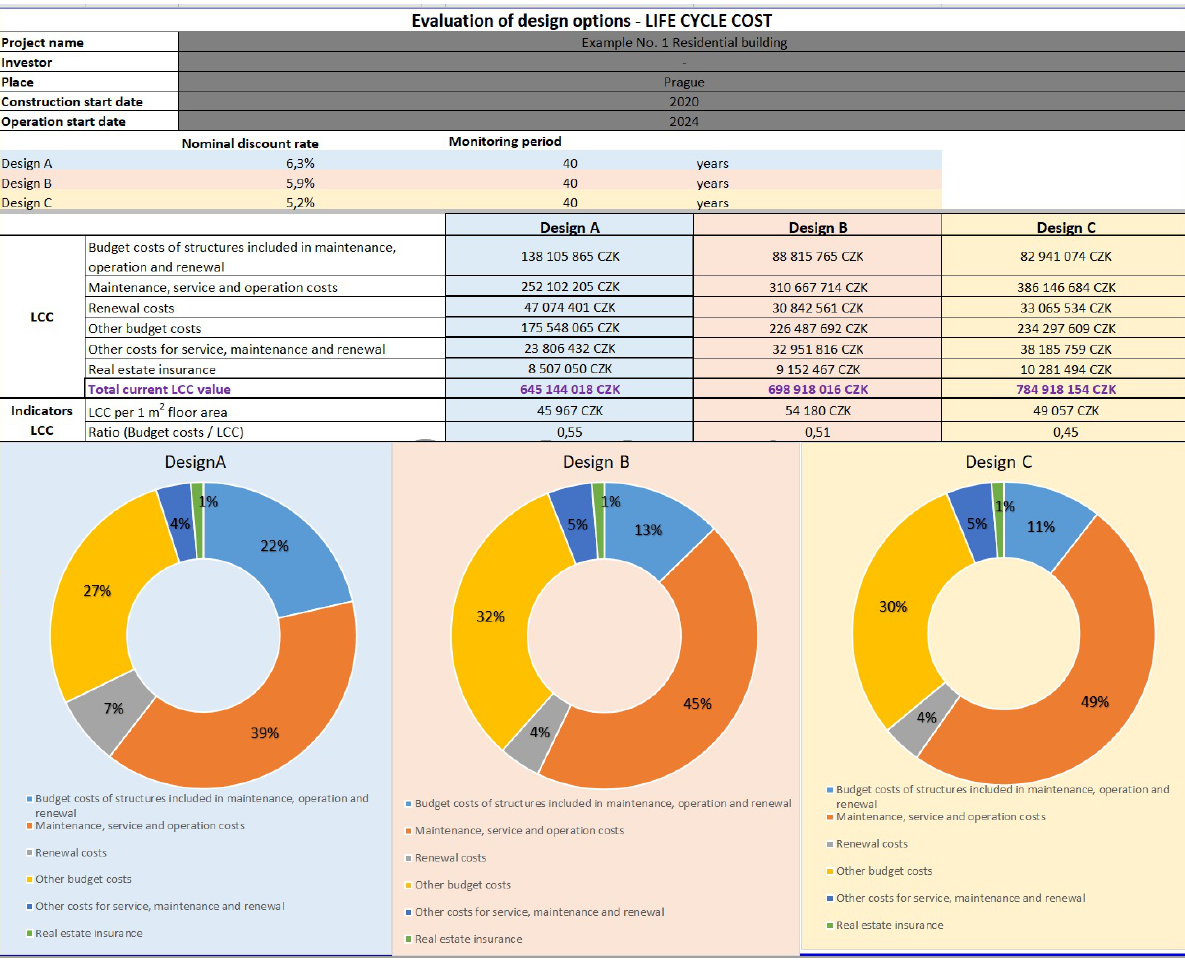
Figure 1. Evaluation of design options - life cycle